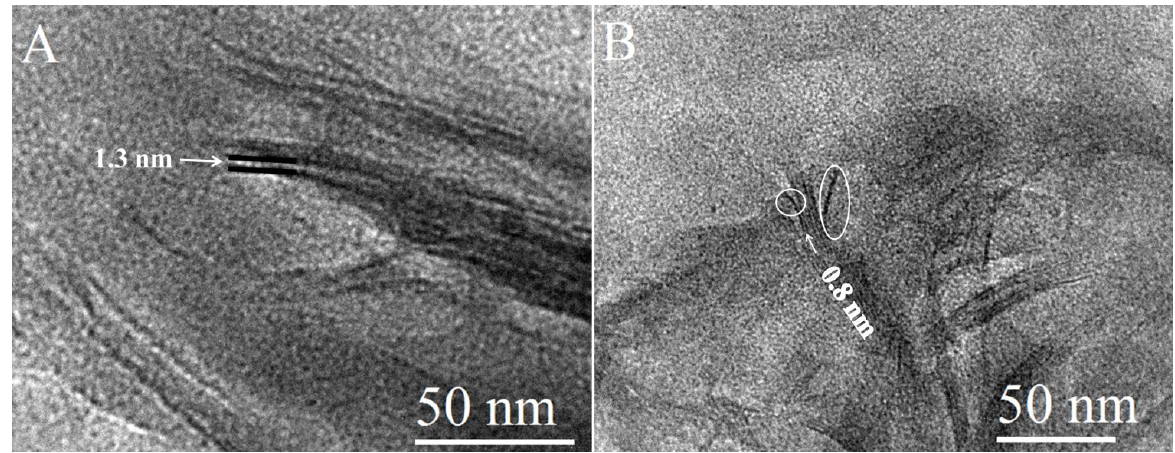
Figure 5. TEM images of NG-MMT